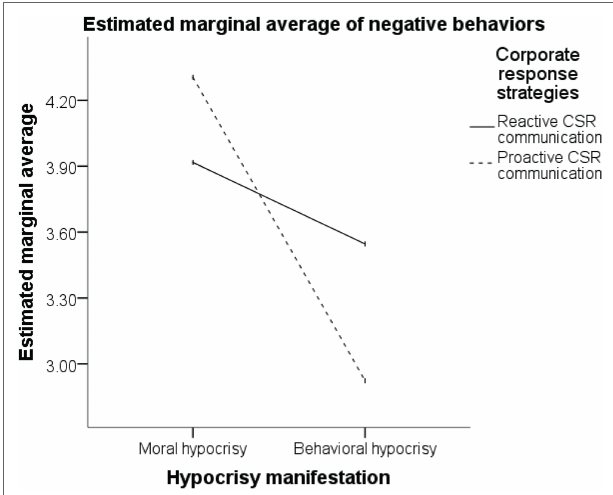
FIGURE 2 | Interaction